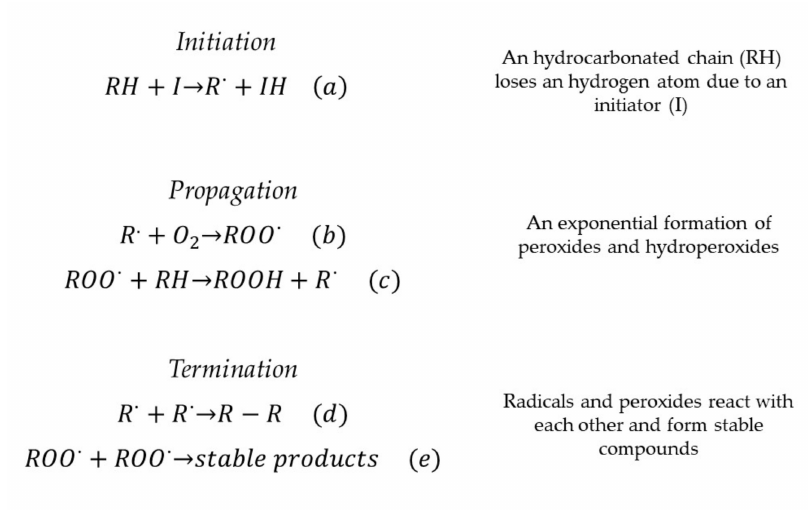
Figure 1. Oxidation process of